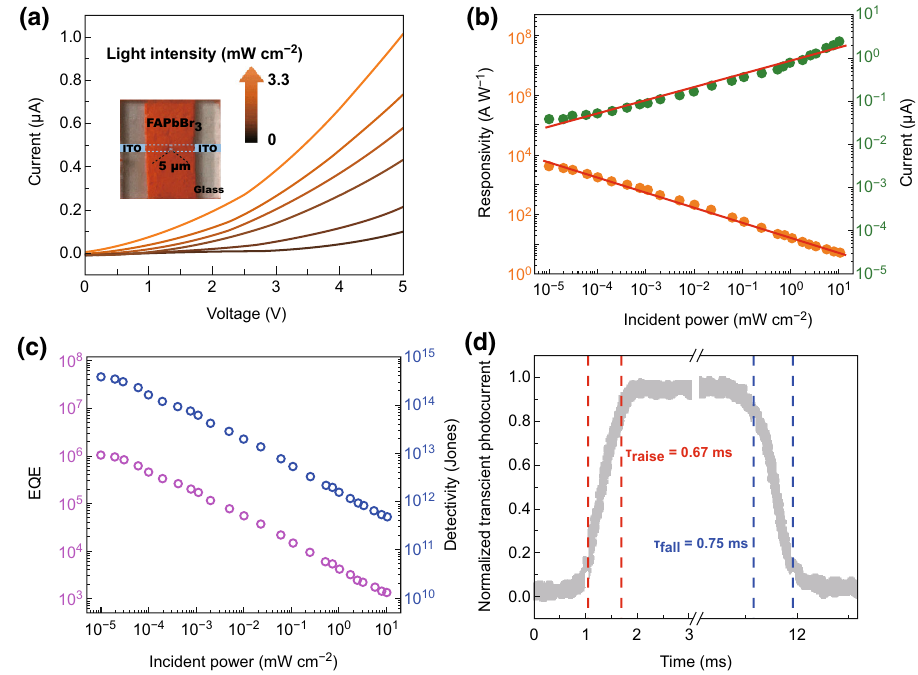
Fig. 2 a Current–voltage characteristics measured under back-side excitation with varying light intensity. b Responsivity and corresponding current as a function of incident light power under back-side illumination. The detector was biased at 5 V. c EQE and detectivity under different light illuminations. d Response time measured by a monochromatic source of 495 nm under back-side illumination and rise time and fall